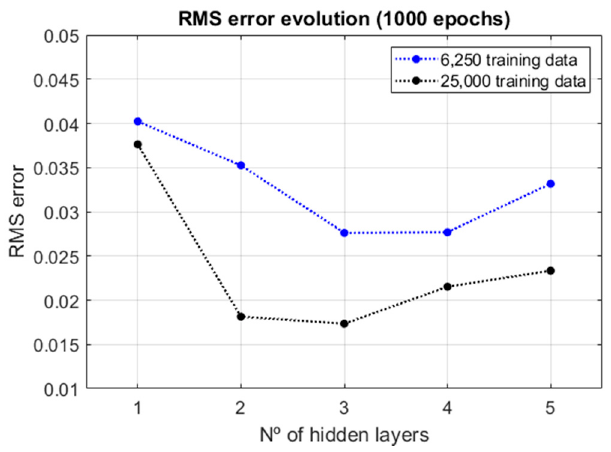
Figure 7. ANN with a different number of hidden layers.